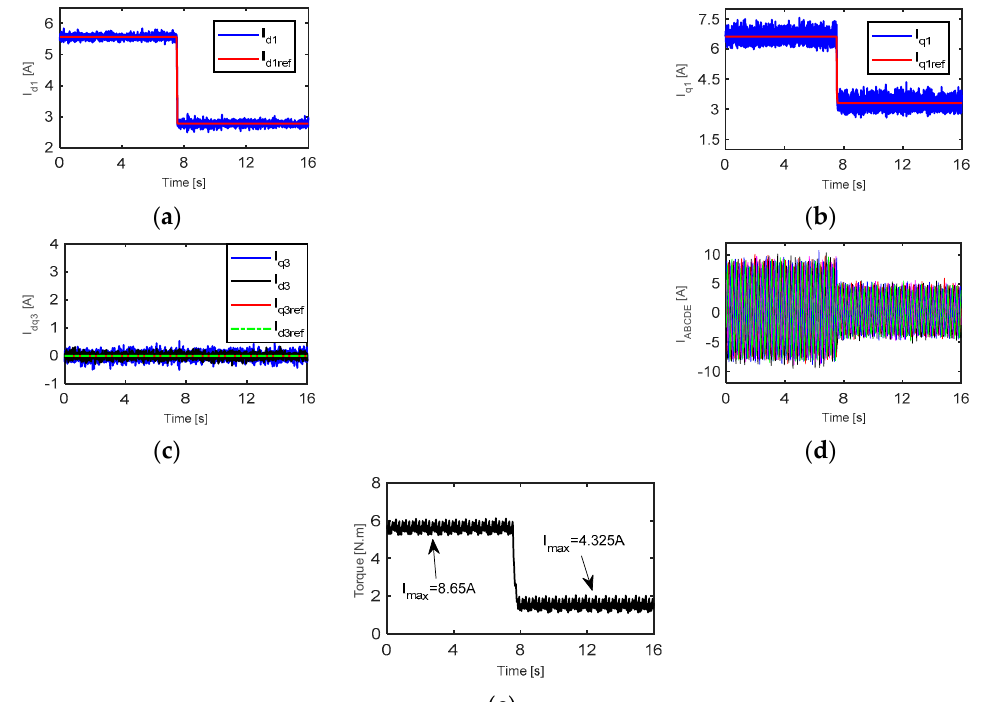
Figure 16. Dynamic performance of drive system at current angle of 50° and current changes from 8.65 A to 4.325 A; ( a ) fundamental d-axis current, ( b ) fundamental q-axis current, ( c ) third-harmonics dq-axis currents, ( d ) five-phase currents, and ( e ) the time response of the output torque. The dynamic performance of the drive system under torque control, at 8.65 A and with current angle changes from 50 ◦ to 20 ◦ , is reported in Figure 17. Figure 17a,b